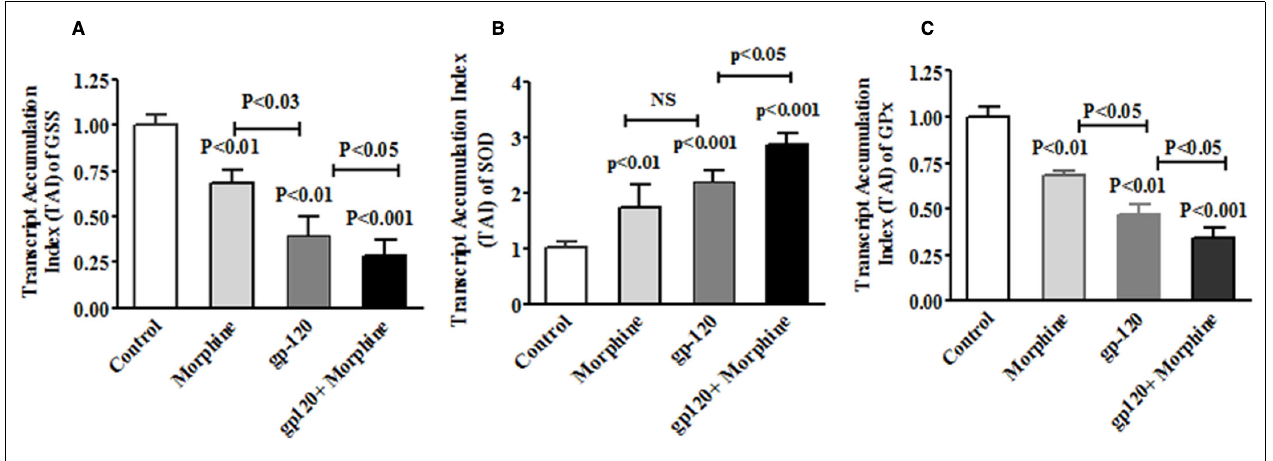
FIGURE 2 | HIV-1 gp120 and morphine effect on redox genes GSS, SOD and GPx expression. Microglia (1 (cid:2) 10 6 cells/ml) were treated with HIV-1 gp120 (100 ng), morphine (0.5 µ M) and HIV-1 gp120 with morphine. Controls were maintained by drug free medium. The end of the incubation,